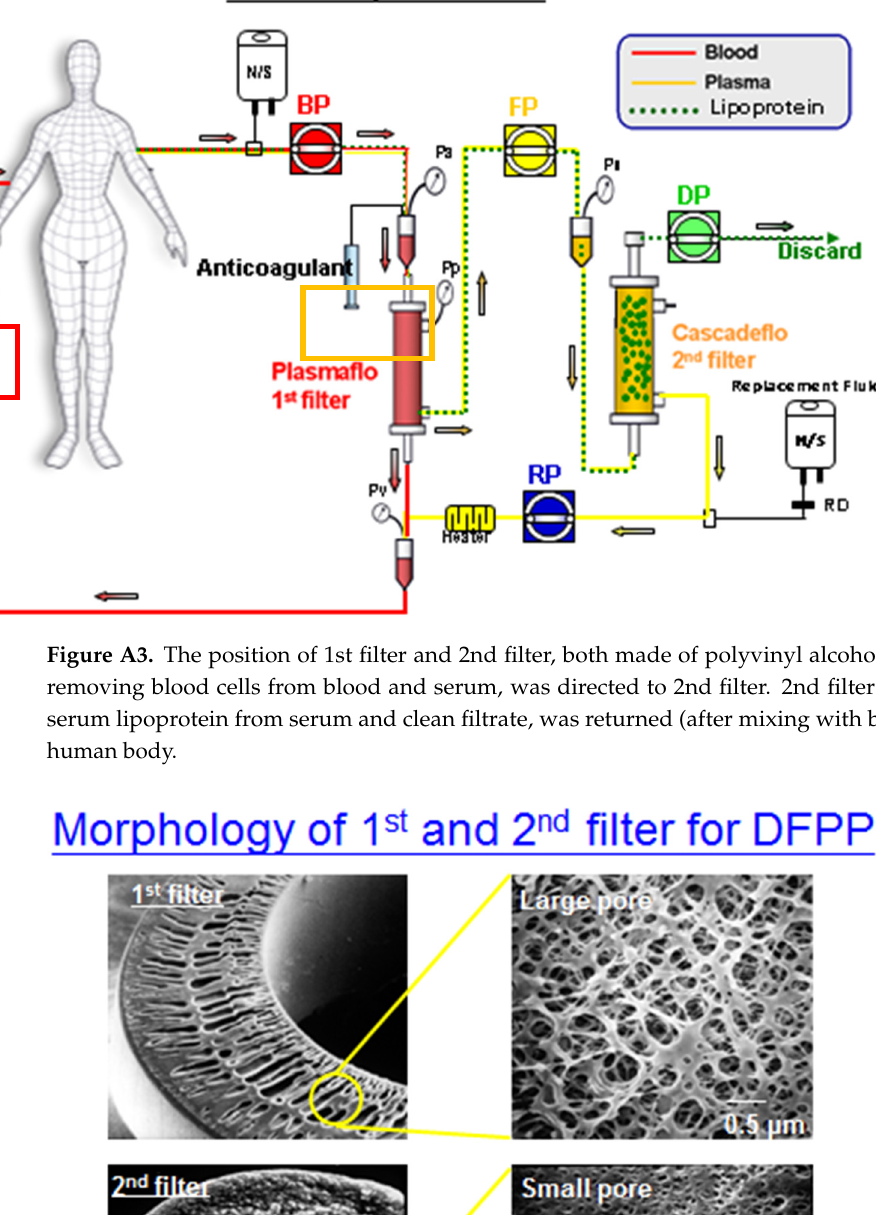
Figure A4. The morphology of 1st filter and 2nd filter (1st filter with larger pores compared to 2nd filter).